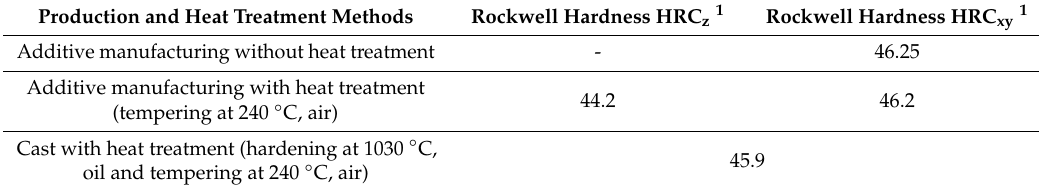
Table 6. Hardness without and with heat treatment of 20Kh13 (DIN 1.4021) steel